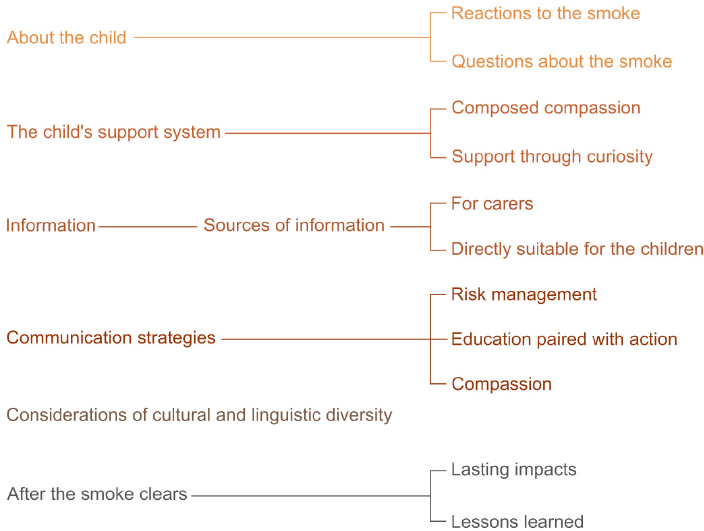
Figure 1. Inductive qualitative conceptual